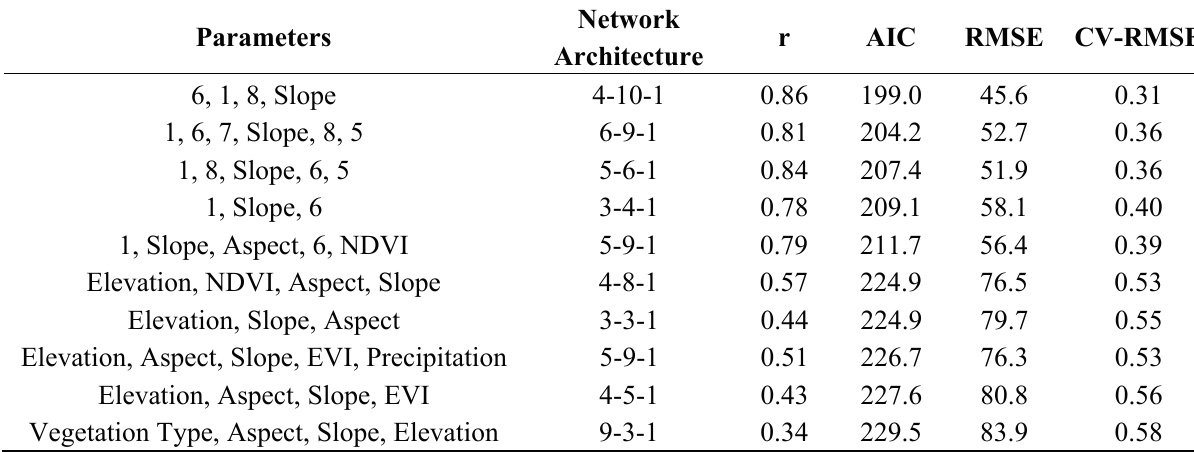
Table 1. Correlation between predicted and observed biomass (r), Akaike’s Information Criteria (AIC), Root Mean Square Error (RMSE) and Coefficient of Variation Root Mean Square Error (CV-RMSE) for the five best performing neural network models constructed with texture metrics (top 5 rows), and the five best performing neural network models constructed without texture metrics (lower 5 rows). The architecture of each neural network is indicated in the form of input-hidden-output units. The Gray Level Co-occurrence Matrix (GLCM) texture metrics used in the highest preforming models were calculated on Band 2, on a 3 × 3 window at an (0,1) offset; they are: 1-mean, 2-variance, 3-homogeneity, 4-contrast, 5-dissimilarity, 6-entropy, 7-second moment, and